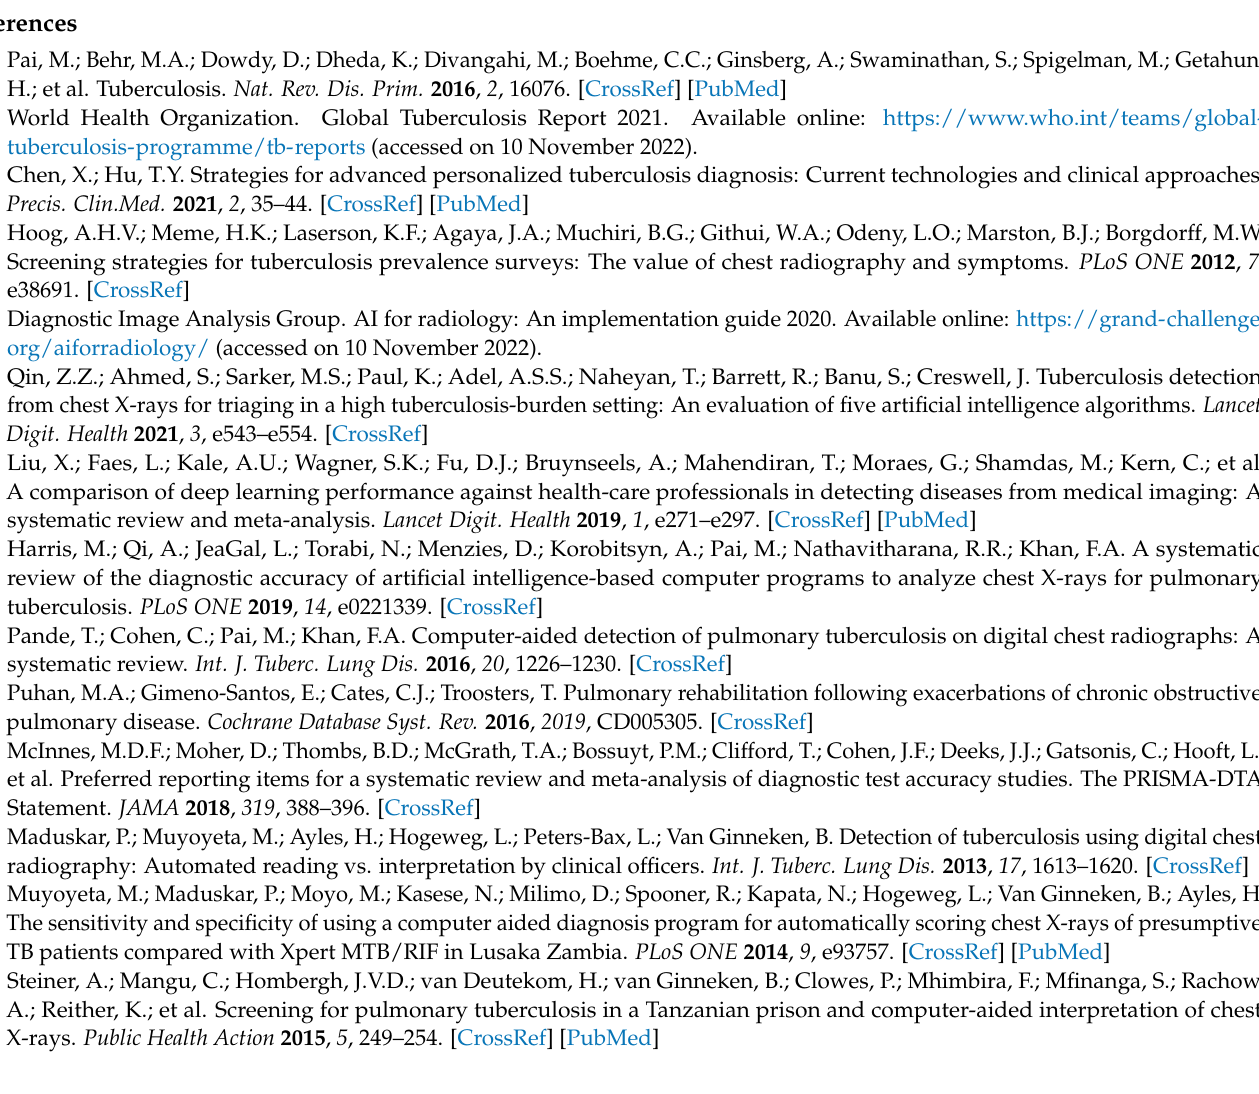
Table S1 Demographics of clinical studies; Table S2 Accuracy information of clinical studies included; Table S3 Accuracy measures reported by development studies; Table S4 Accuracy measures